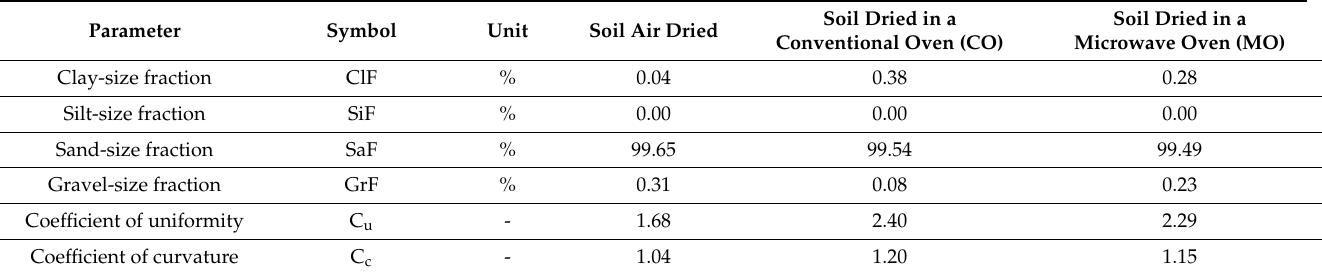
Table 5. Basic properties of medium sand (MSa—SP).